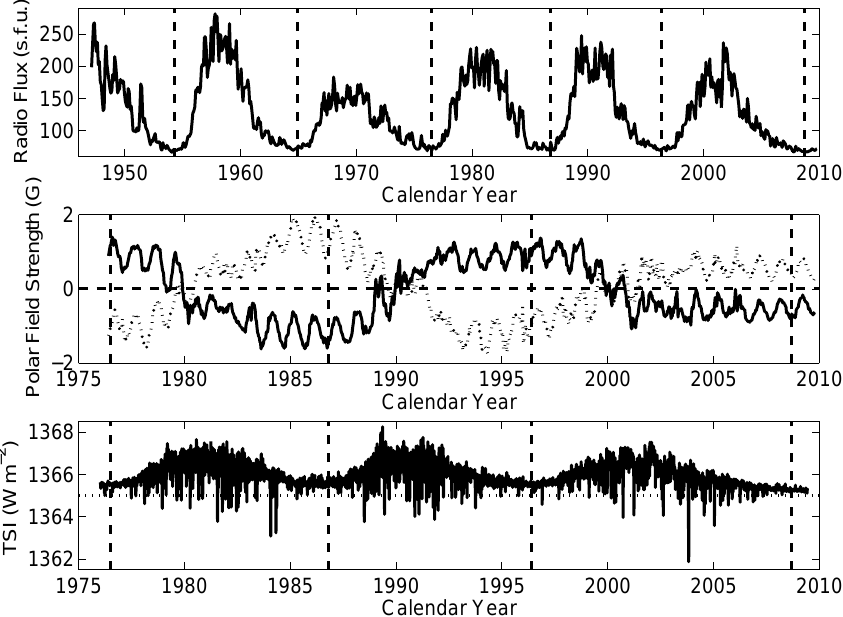
Fig. 3. Top panel: the monthly mean values of the solar radio adjusted flux density at 10cm wavelength measured by Ottawa/Pentiction from February 1947 to May 2009. Middle panel: the monthly mean values of the Sun’s polar field strength in the Northern (solid line) and Southern (dashed line) Hemispheres, observed at Wilcox Solar Observatory (WSO) from June 1976 to September 2009. Bottom panel: the daily total solar irradiance (TSI) of the PMOD composite from 1 December 1976 to 9 June 2009. The vertical dashed lines mark the minimum times of sunspot cycles.